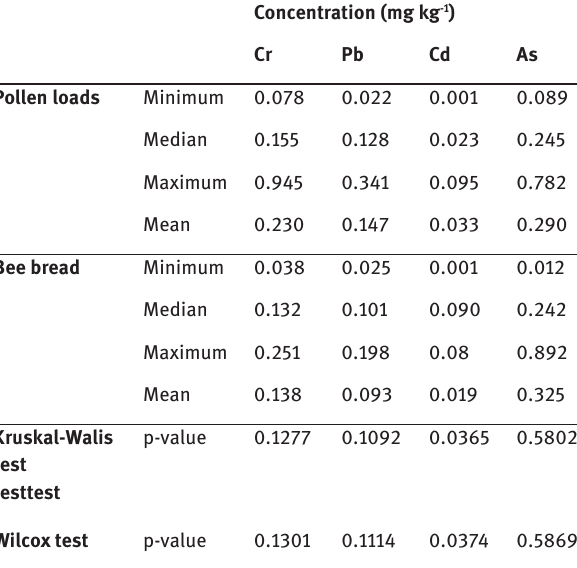
Table 2: Toxic elements in bee bread from Lower Silesia. Apiary